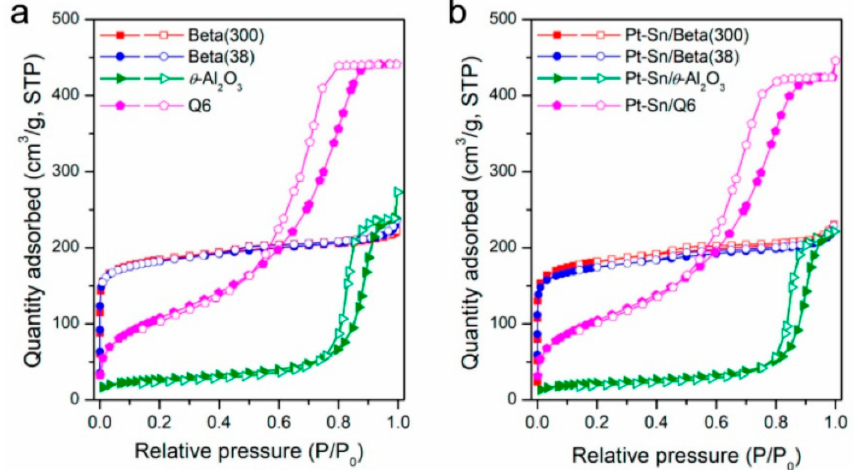
Figure 1. N 2 adsorption–desorption isotherms of ( a ) supports and ( b ) supported Pt-Sn catalysts. Table 1. Porous properties of supports and supported Pt-Sn catalysts obtained by N 2 adsorption–desorption isotherm.